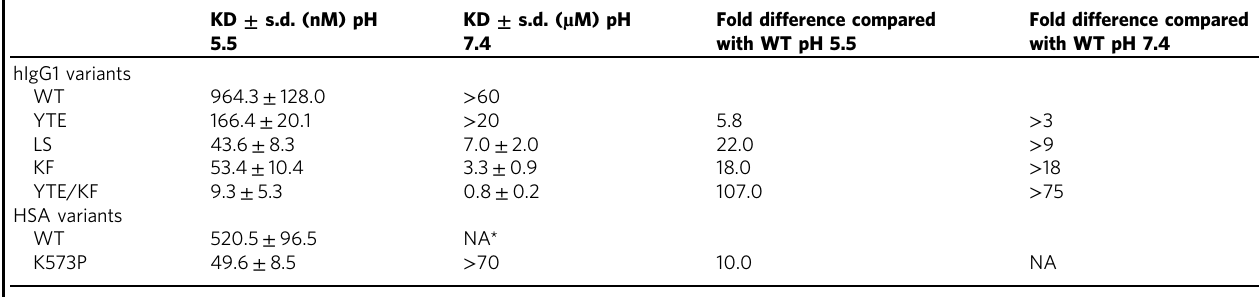
Table 1 KD values derived from MicroScale Thermophoresis analysis KD ± s.d. (nM) pH